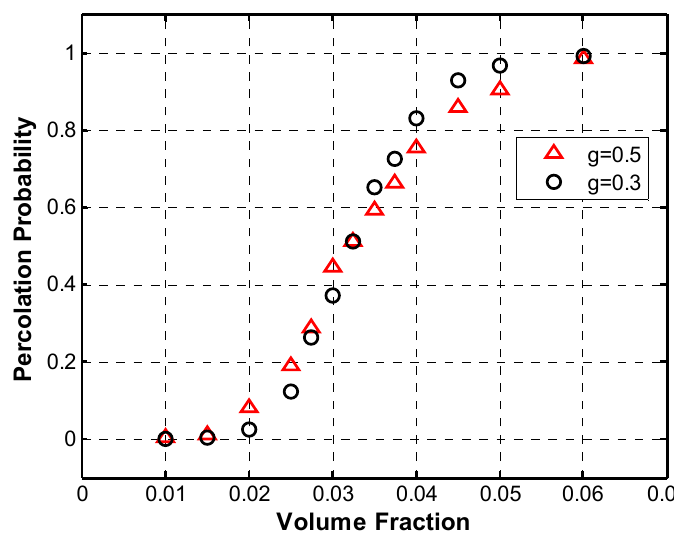
Figure 20. Percolation probability curves intersect at the percolation threshold, for AR = 140. Keeping all the other parameters constant, the aspect ratio was increased from 140 to 240, and a range of volume fractions were simulated for g = 0.5 and g = 0.3. From Figure 21, it can be seen that the curves intersect at two different points, at 1.75 vol. % and again at approximately 1.9 vol. %. The corresponding percolation probability is 0.386 and about 0.55, respectively, close to the 0.5 percolation probability value, as expected from [19].